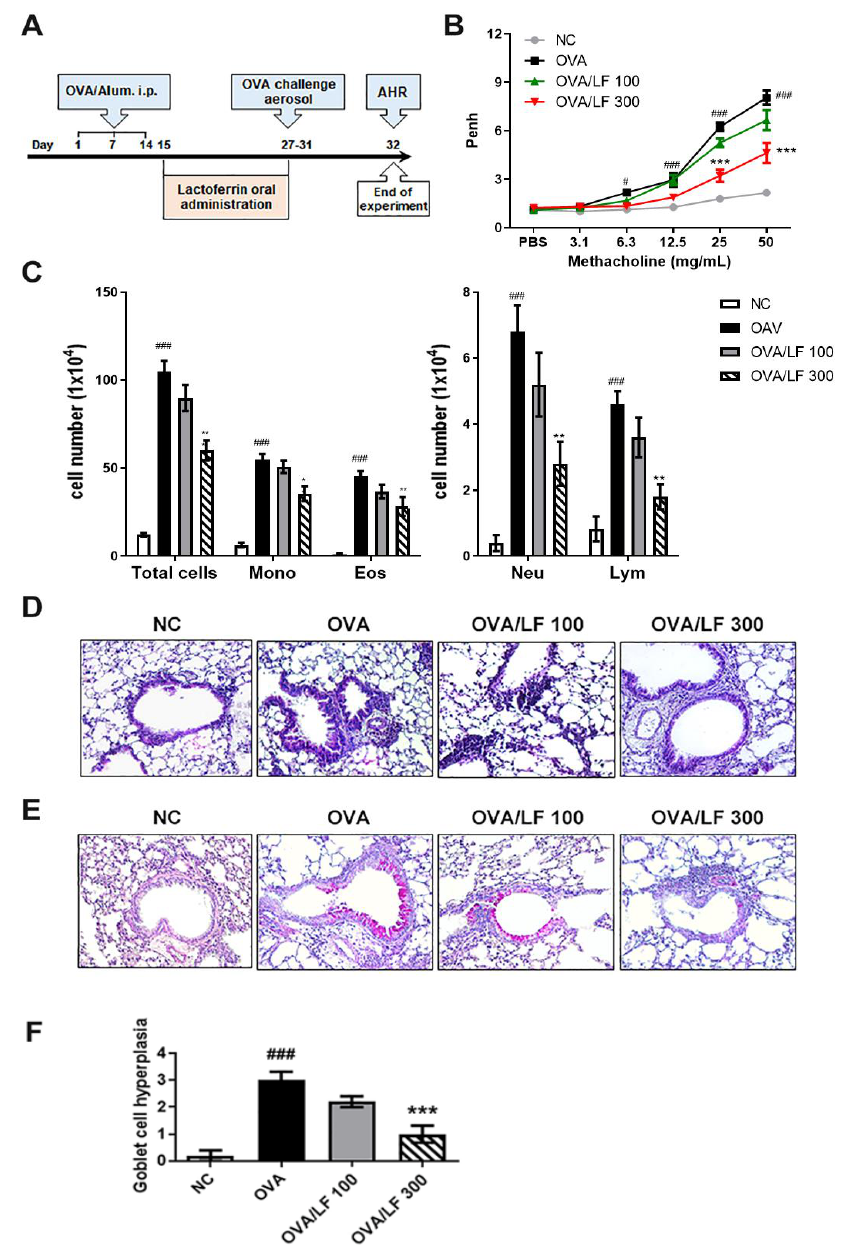
Figure 1. Effect of lactoferrin on AHR and airway inflammation. ( A ) Experimental procedure of the OVA-induced AHR animal experiment. Mice were randomly divided into 4 groups (5 mice/group): normal control (NC), ovalbumin (OVA)-sensitized, OVA-sensitized and low-dose lactoferrin (OVA + LF 100 mg/kg), and OVA-sensitized and high-dose lactoferrin (OVA + LF 300 mg/kg). The NC group was not sensitized with OVA and treated with lactoferrin. Mice in the other groups were i.p. injected with 20 μg OVA containing 2% alum on the 1st, 7th, and 14th days. On the 15th to 27th days, mice in the OVA/LF 100 and OVA/LF 300 groups were administered 100 or 300 mg/kg lac- toferrin orally every day. On the 27th to 31st day, mice in the OVA, OVA/LF 100, and OVA/LF 300